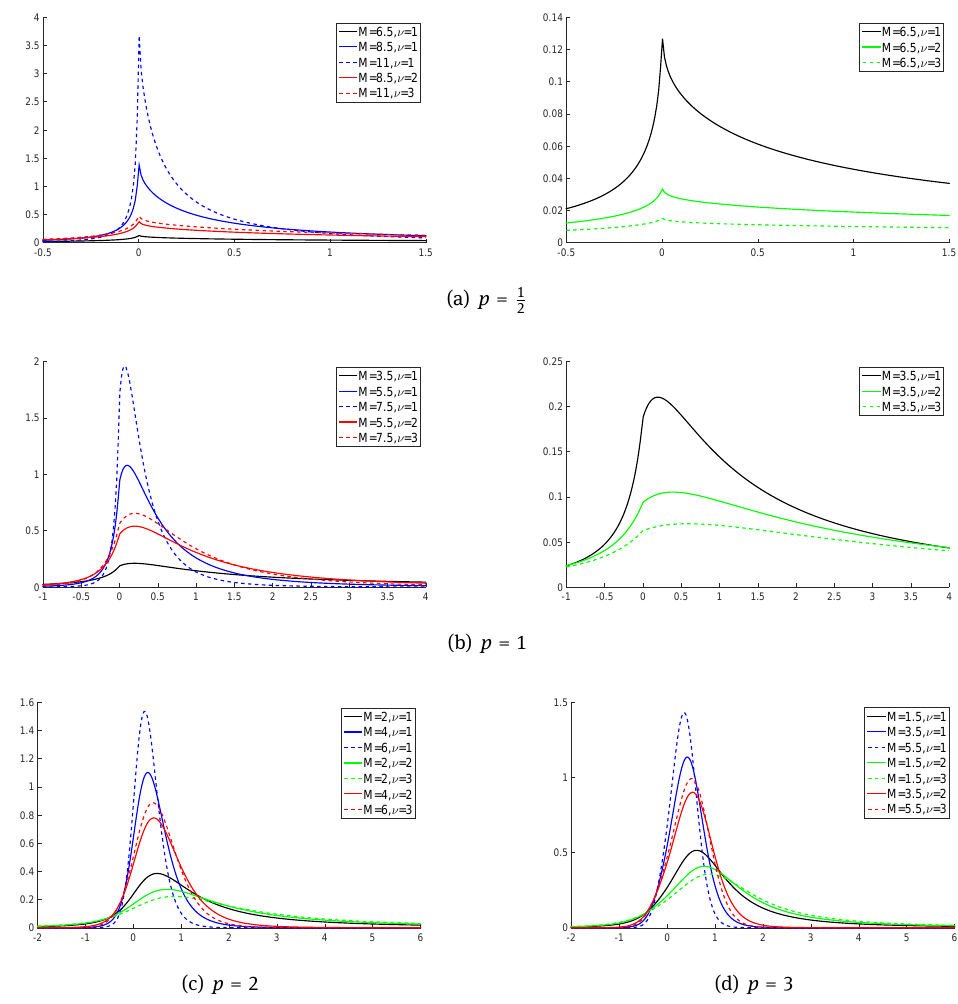
, and several choices of the parameters M > 3 PT 7; M , ν